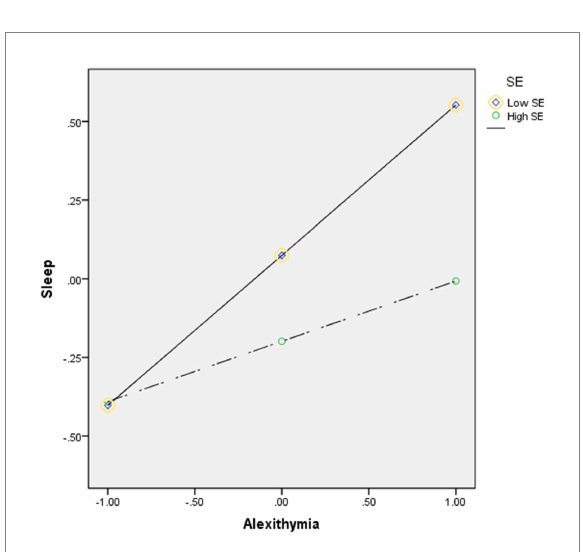
FIGURE 3 Moderation effect of self-esteem between alexithymia and sleep disturbance. High and low levels of self-esteem represent one standard deviation above and below the mean. SE, self-esteem.